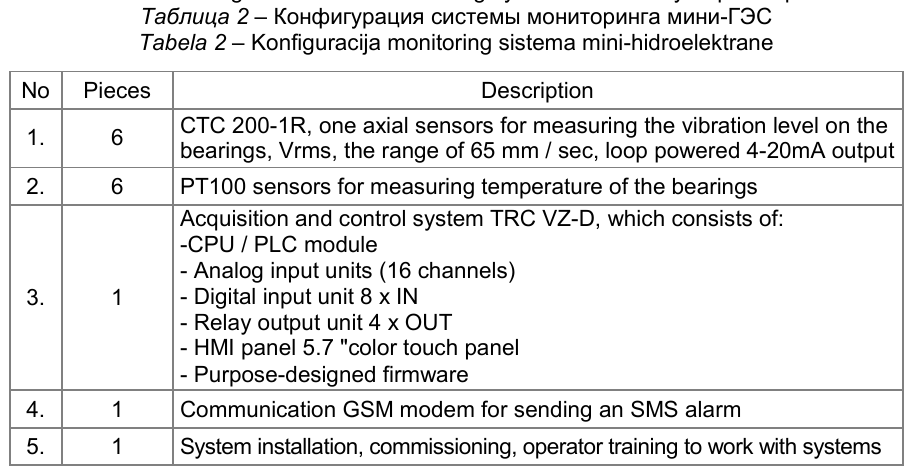
Table 2 – Configuration of the monitoring system of a mini hydropower plant